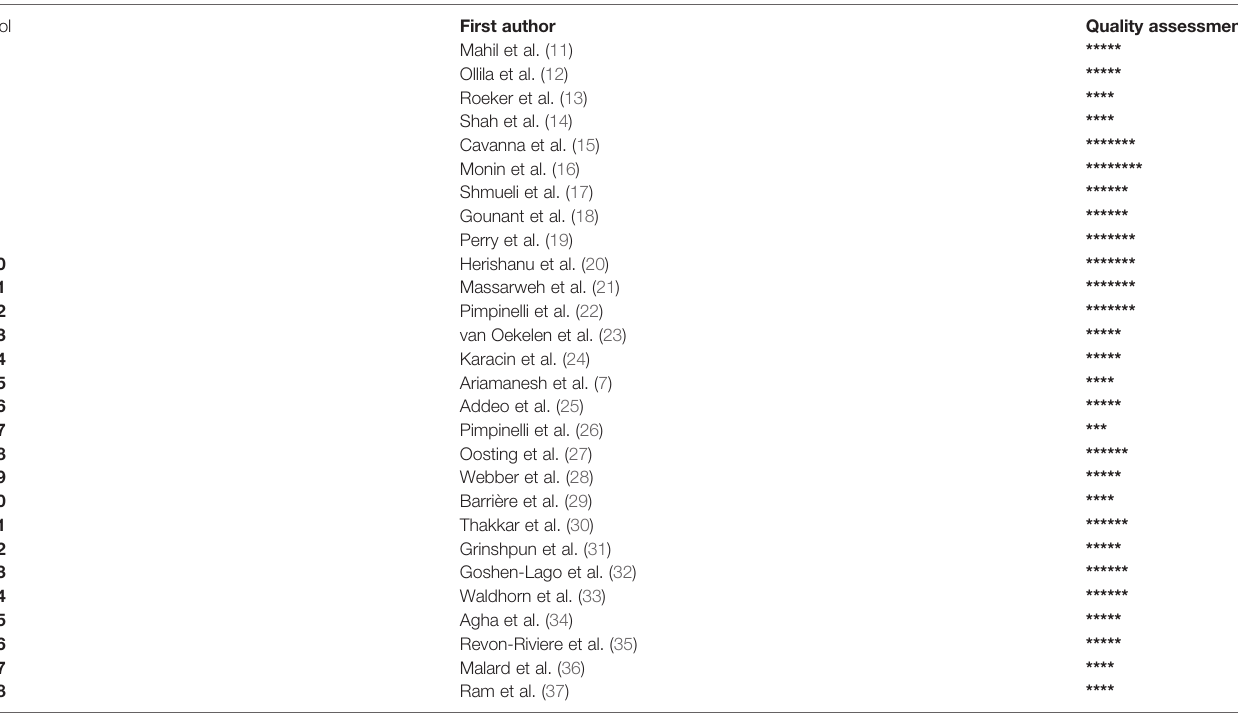
TABLE 1 | Methodological quality summary for each included study. Col